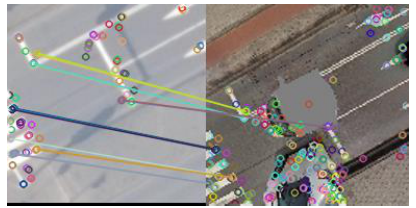
Figure 13 Matched KAZE keypoints in the second scene and third iteration Blurring the images prior to resampling them further improves